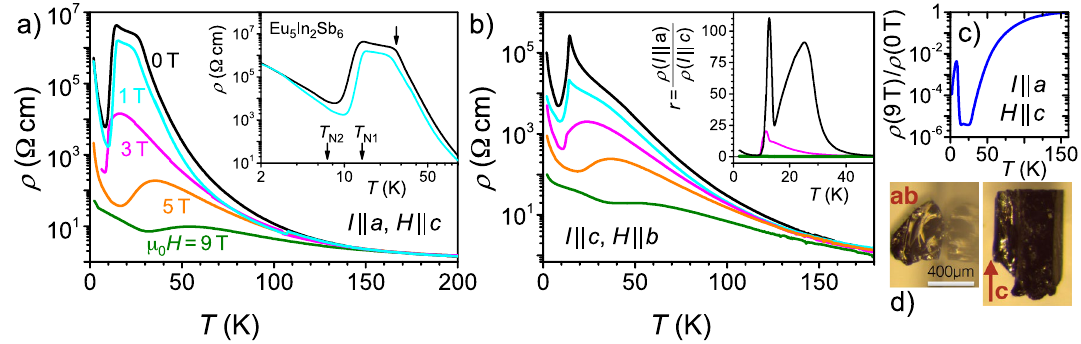
Figure 6. Resistivity ρ( T ) in dependence on temperature for current I along different directions: ( a ) I (cid:31) a and H (cid:31) c and ( b ) I (cid:31) c and H (cid:31) b . Inset in ( a ): Zoom into the low- T range on a logarithmic T -scale. At zero field, a kink is observed around 27 K (arrow). Inset in ( b ): Ratio r of resistivities for the different configurations shown in ( a ) and ( b ). The zero-field maximum near 27 K is suppressed with field. At H = 9 T, r is of order 0.3 (green curve). All panels share the same color code for magnetic fields. ( c ) Ratio of resistivities measured at fields of 9 T and 0 T, as shown in ( a ). ( d ) Photographs of the sample, scale bar 400 µ Supplementary Fig. S5] before dropping by several orders of magnitude below T N1 . For I (cid:31) c , a smaller hump is detected, in agreement with Ref. 22 . In consequence, the ratio of resistivities, r = (ρ I � a )/(ρ I � c ) measured for